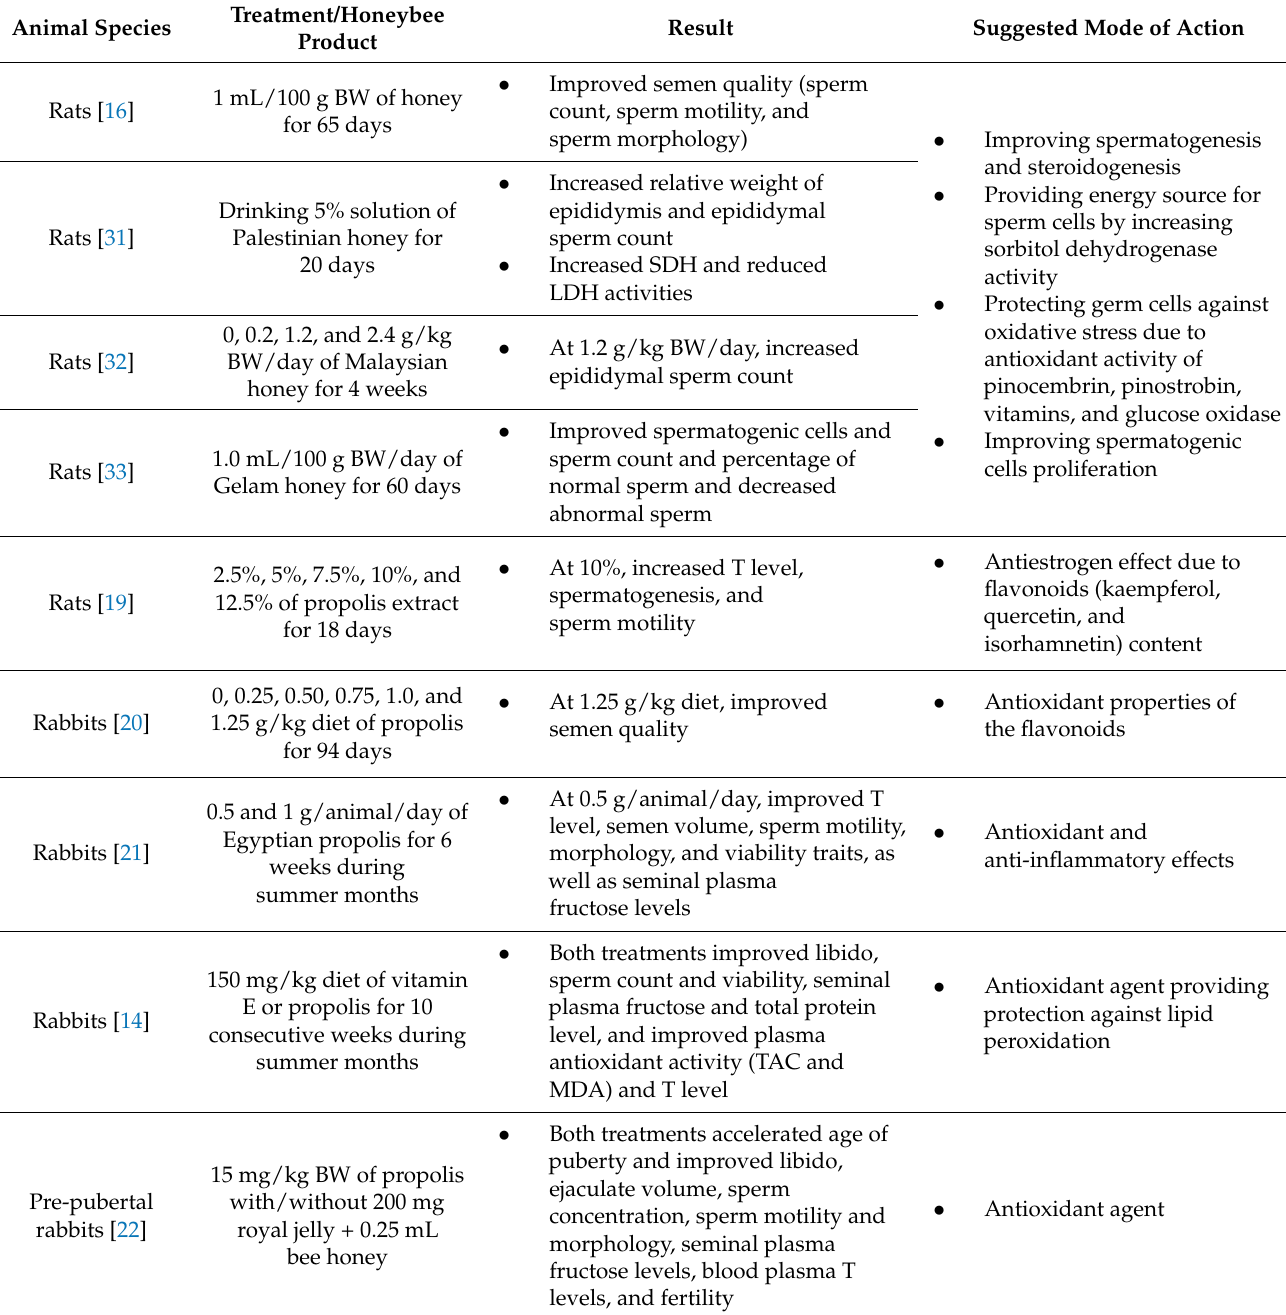
Table 3. Summary of some recent studies on the effects of different honeybee products on reproductive performance of males in different mammalian